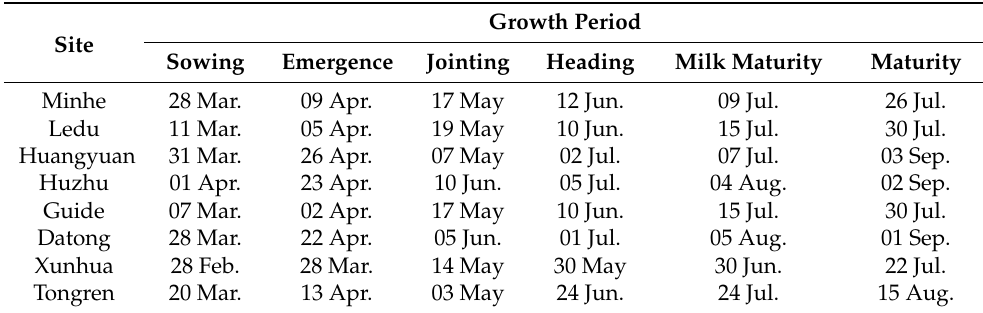
Table 1. The multi-year average of the growth period days is used to represent the local general growth period. The full growth period of spring wheat is from March to August. Table 1. Spring wheat growth period at 8 sites of Qinghai,